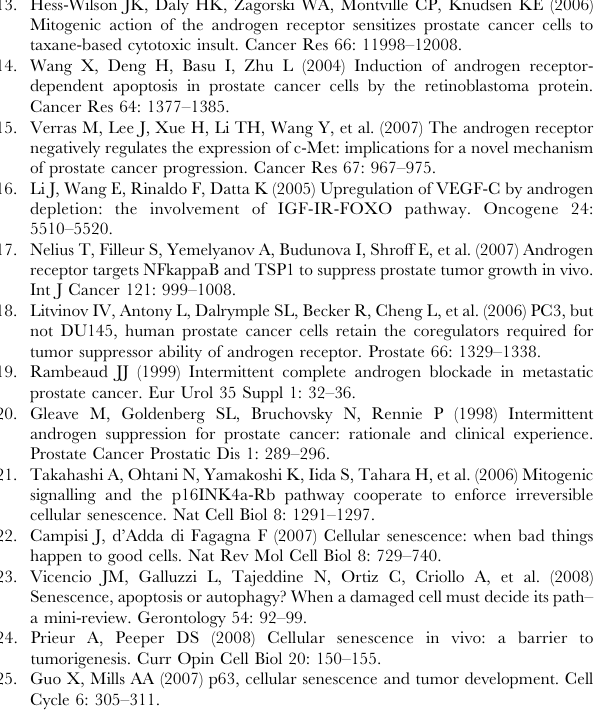
Figure S5 Regulation of cytokine secretion by AR. PC3- AR cells were treated with Dox (D) in the presence of DHT (DD) or DHT and Flutamide (DDF) and conditioned media collected after 3 and 5 days. Cytokines were measured in triplicate using multiplex ELISA assay. Only the factors whose expression is changed in the presence of DHT are shown. Statistical significance was calculated by one-way analysis of variance (ANOVA). * indicates P , 0.03 and ** P , 0.003, respectively. Table S1 Antibodies used in the study. Table S2 PCR primers/conditions used in this